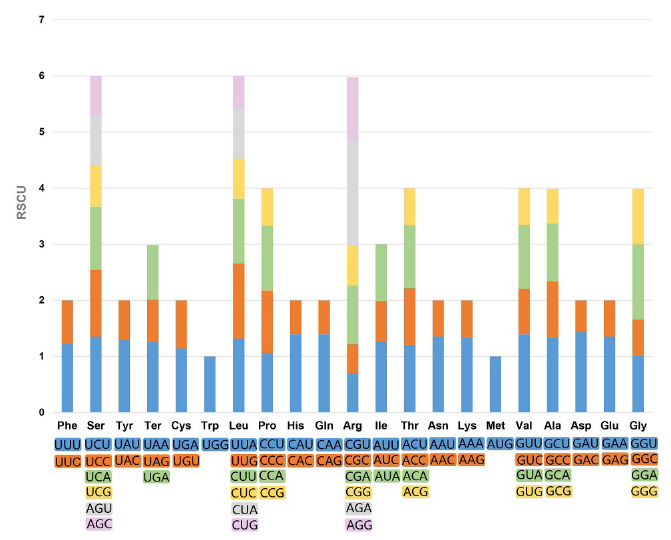
Fig. 3: The RSCU values of all protein-coding genes in the chloroplast ge- nome of G. triflora .